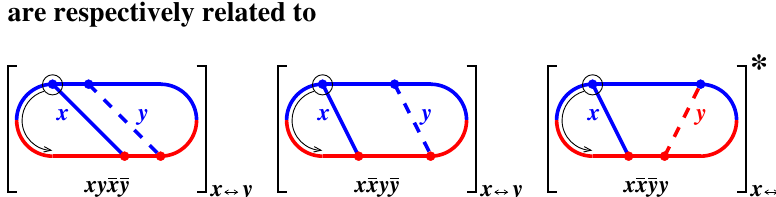
Figure 10 . Relation of all but one Class II virtual diagram ((cid:12)gure 5) to real g via front-end